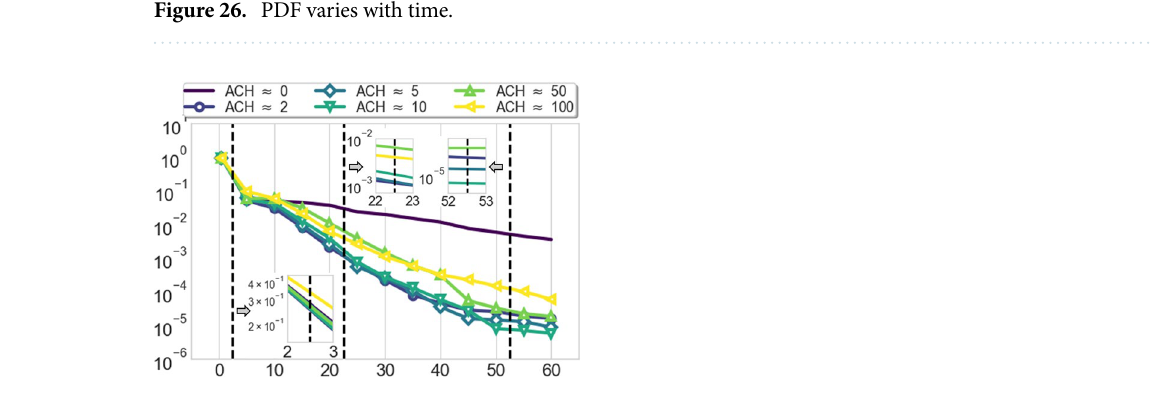
Figure 26. PDF varies with time.